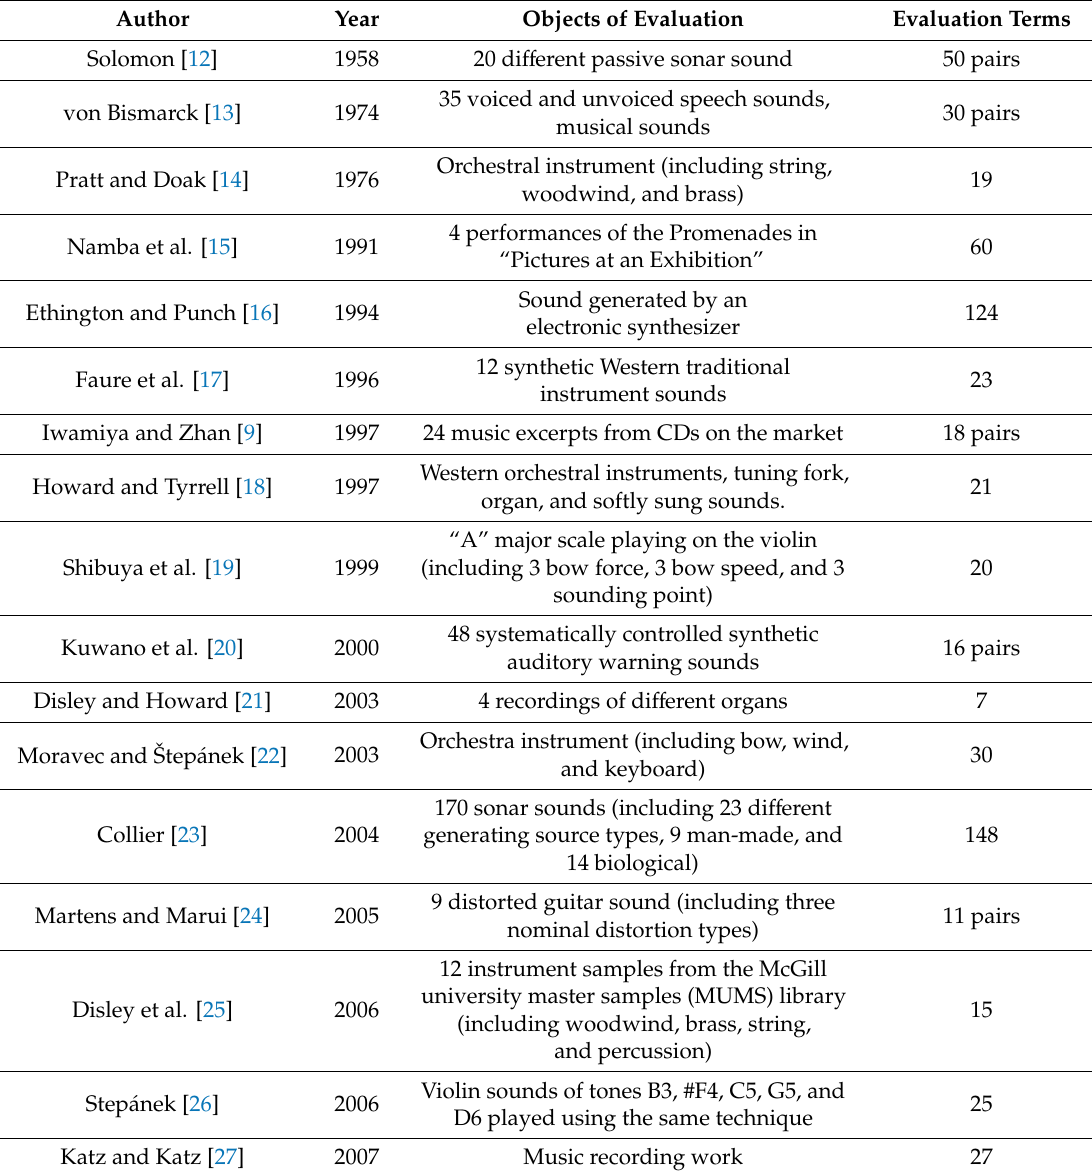
Table 1. Previous studies on timbre evaluation